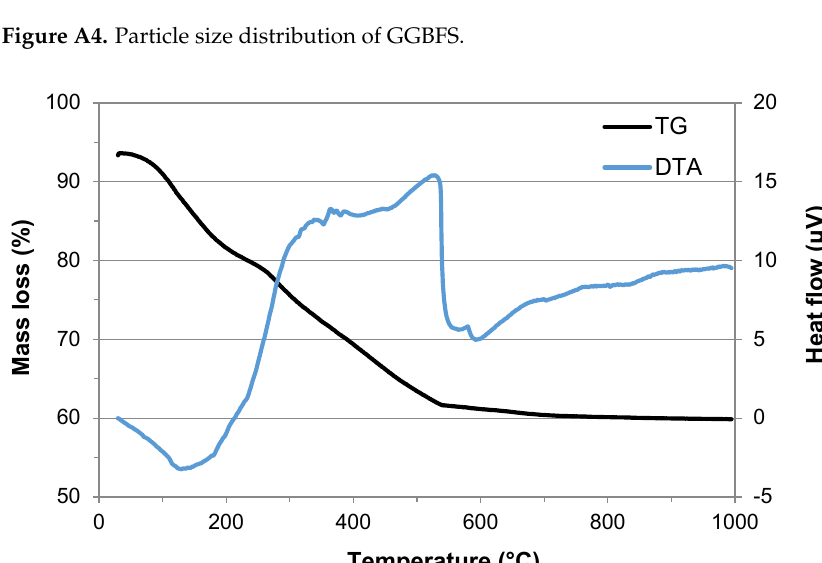
Figure A5. TG and DTA curves of sample S-4.5.